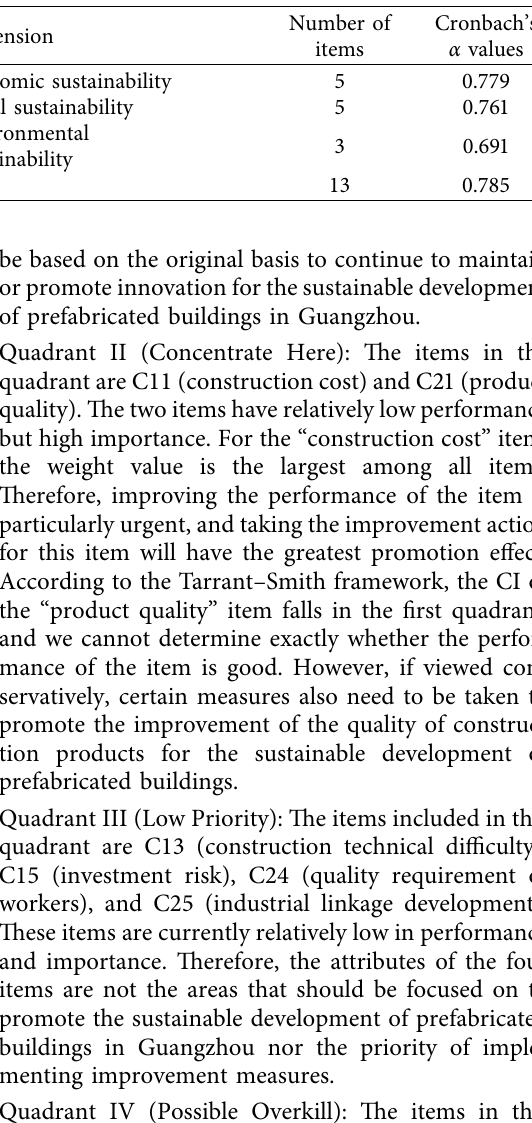
Table 3: Reliability